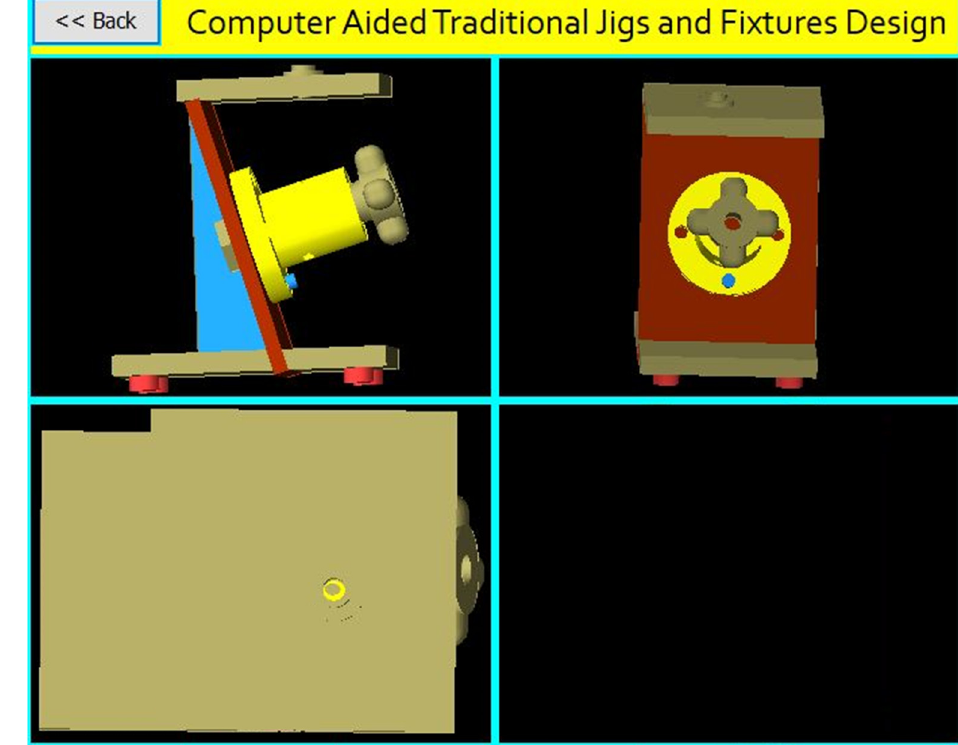
Figure 57. Computer-aided design of a jig for the cylindrical part. The software shows the jig views in Figure 58. The button (Jig Projections) is used to draw the jigs views on the interface screen to show the details of the design of tradi- tional jigs and fixtures.